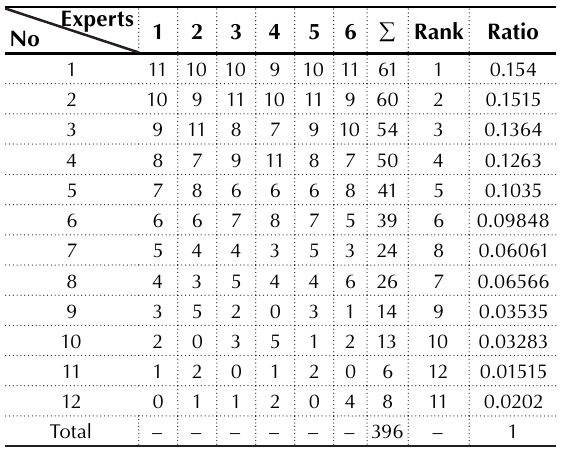
Table 4. Matrix of transformed ranks